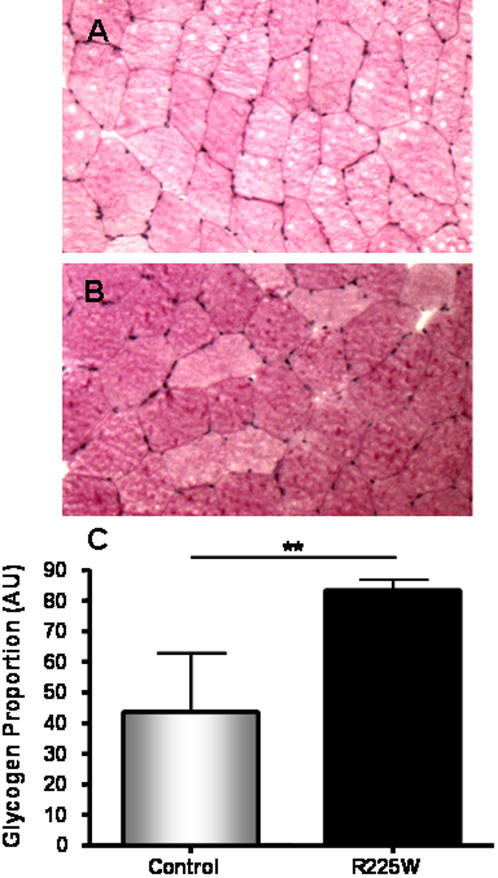
Glycogen content of vastus lateralis for R225W and control subjects.Muscle sections were prepared and stained with PAS, as described in the methods section (A: control, B: R225W). C: quantification of glycogen content via imaging software. Means +/− SD. n = 5, Student's t-test, **p = 0.002.